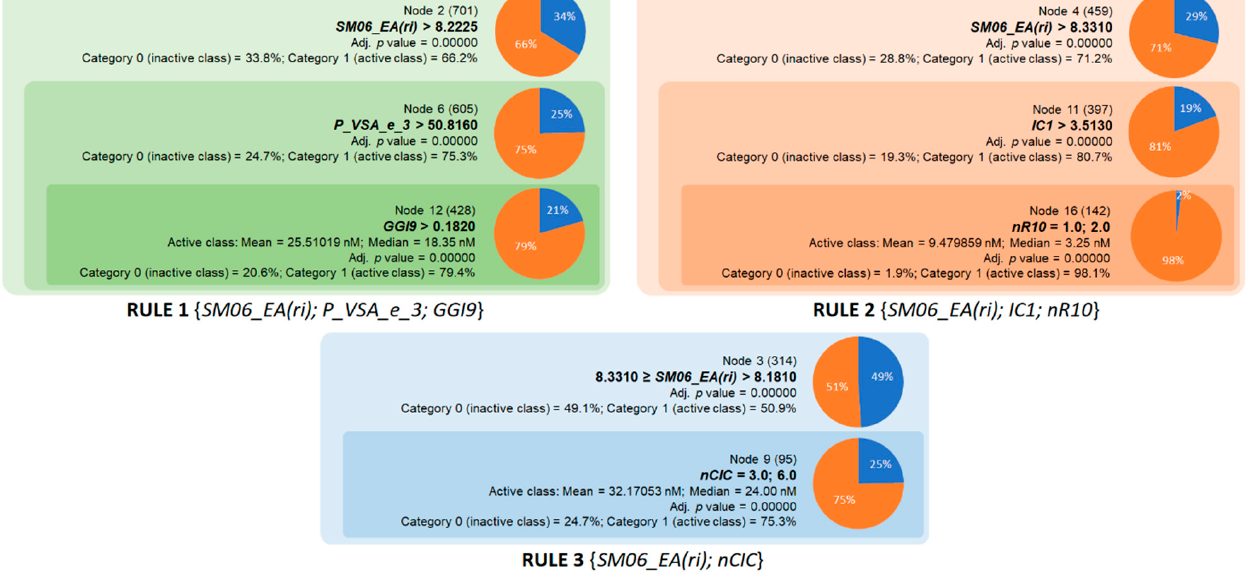
Figure 3. Overview of the three chemical rules elaborated in the current study and applied to predict BACE1 inhibition. Table 4. Molecular descriptors included in the three BACE1 rules.